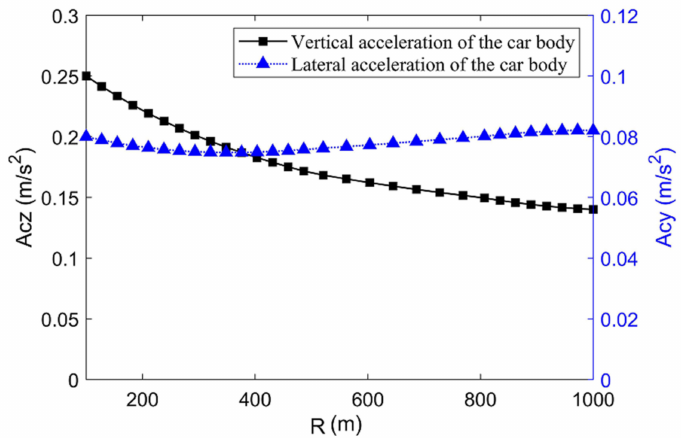
Figure 10. Maximum of vehicle body